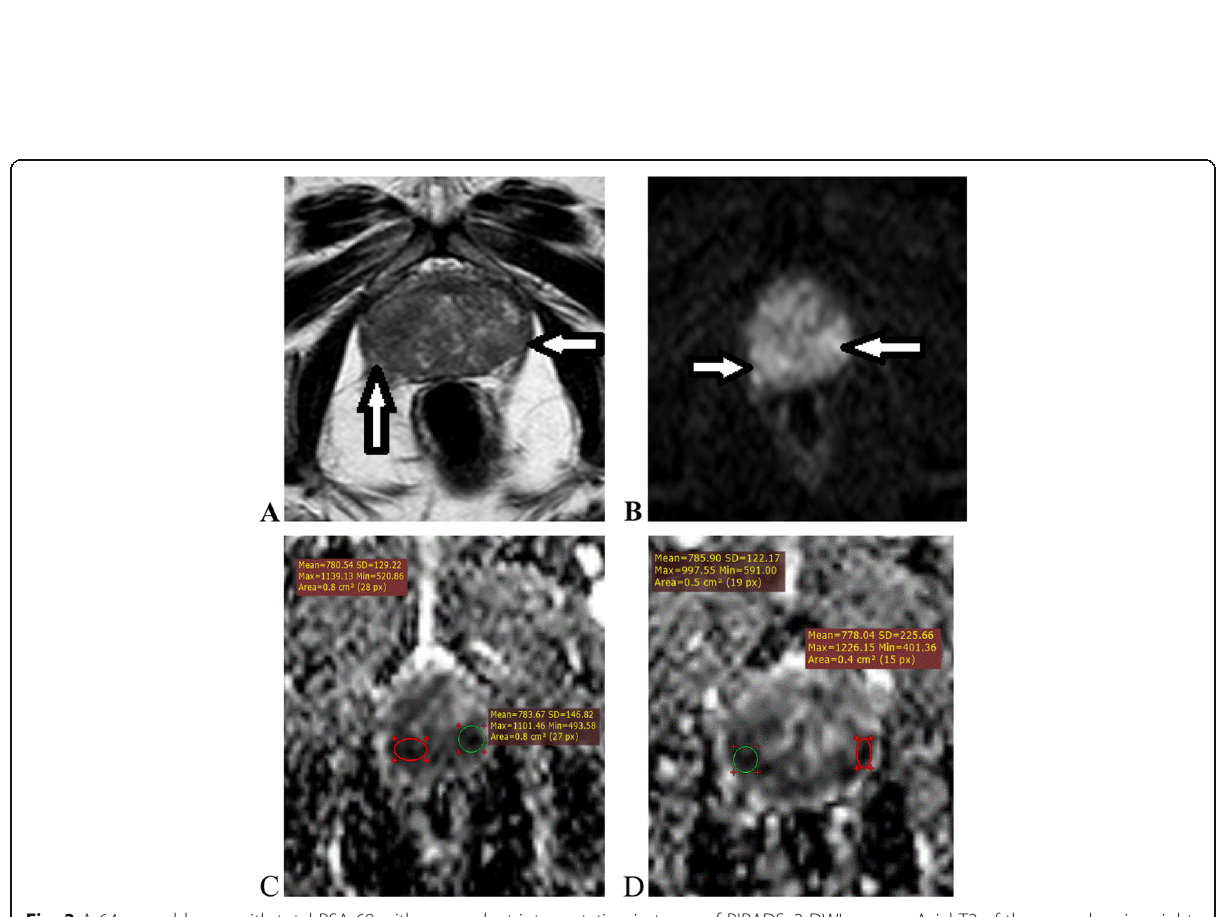
Fig. 3 A 64-year-old man with total PSA 68 with concordant interpretation in terms of PIRADSv2 DWI score. a Axial T2 of the apex showing right peripheral zone non circumscribed homogenous low signal intensity lesion < 1.5 cm. b DWI of b 800 shows a markedly hyperintense focal lesion in right PZ (arrow). CADC map also shows marked hypointensity of the lesion with mean ADC value 0.803. The qualitative DWI score was 4 for readers 1 and 2. The ADC ratio between benign prostatic tissues was 1.58. Histopathology was adenocarcinoma GS 3 + 4 = 7; tumor volume = 1.5 cm 3 ;